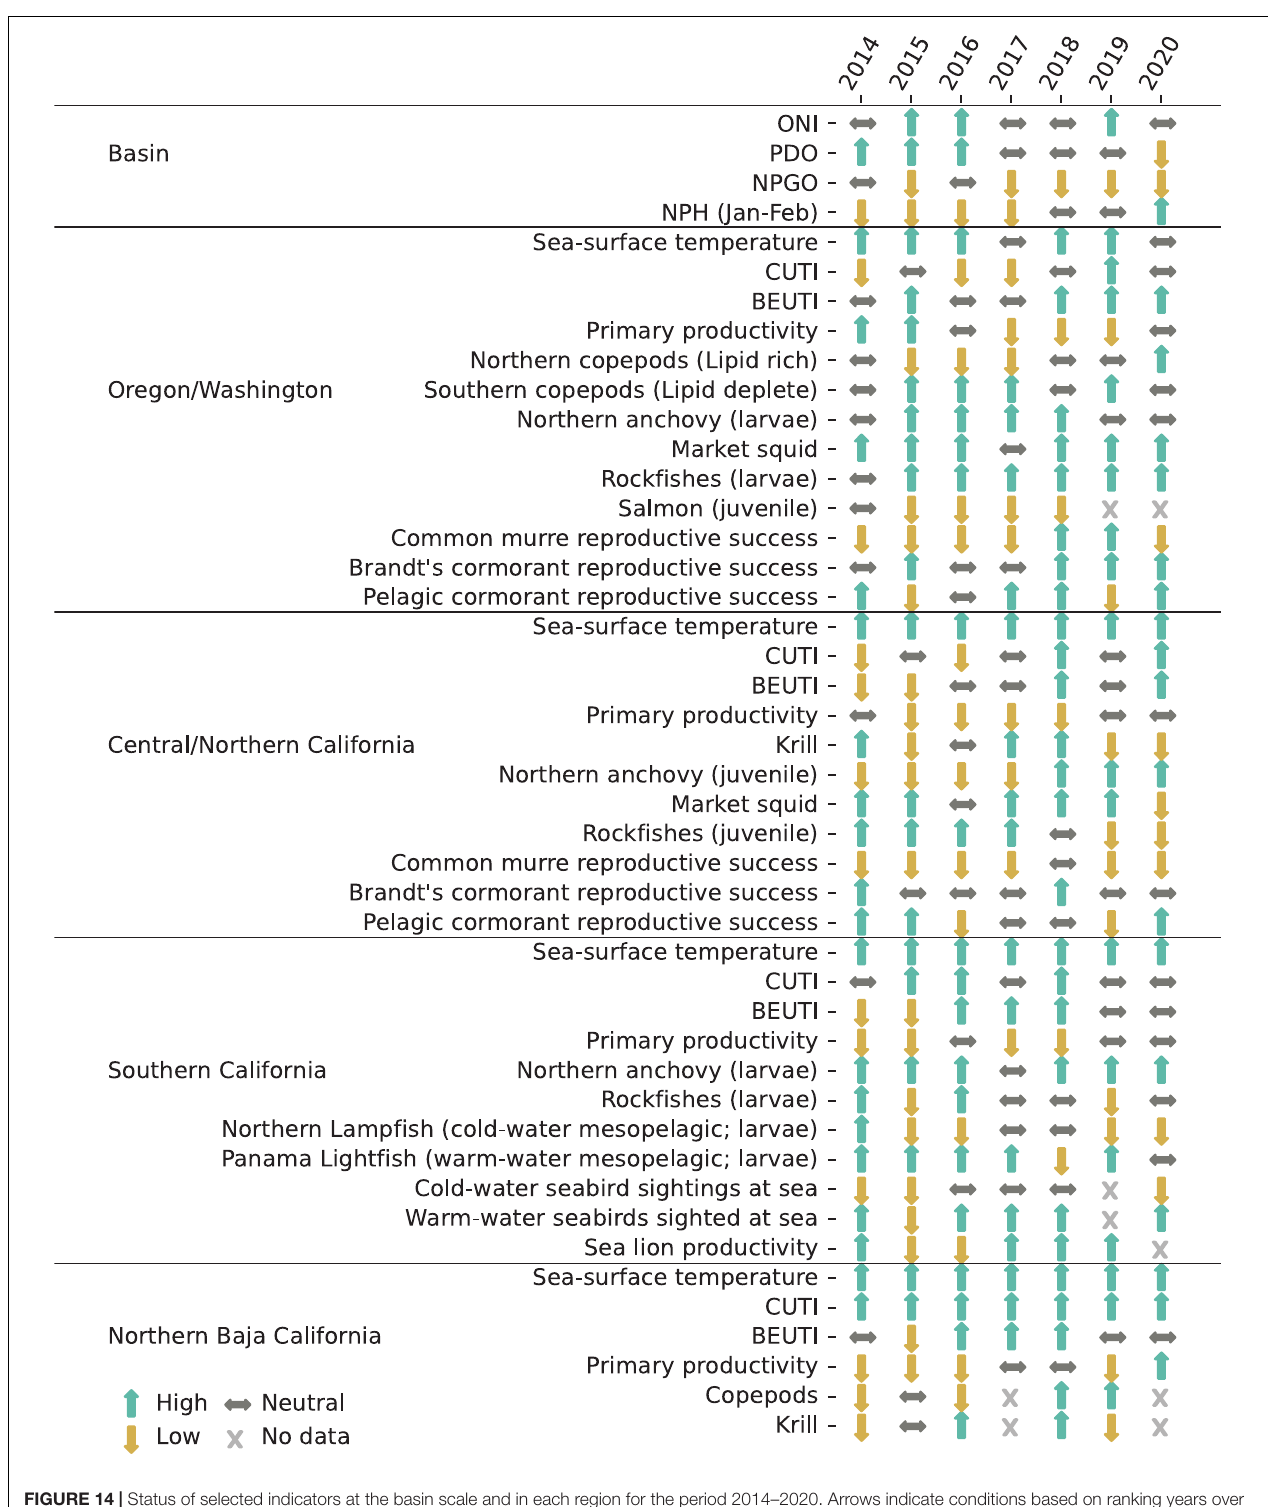
FIGURE 14 | Status of selected indicators at the basin scale and in each region for the period 2014–2020. Arrows indicate conditions based on ranking years over the long-term means reported for each indicator in previous sections of this article. Arrows pointing upward indicate the value was ranked in the greatest 1/3 of years sampled, sideways arrows the middle 1/3, and downward arrows the least 1/3. We note that sampling periods and effort varied by indicator as described in the